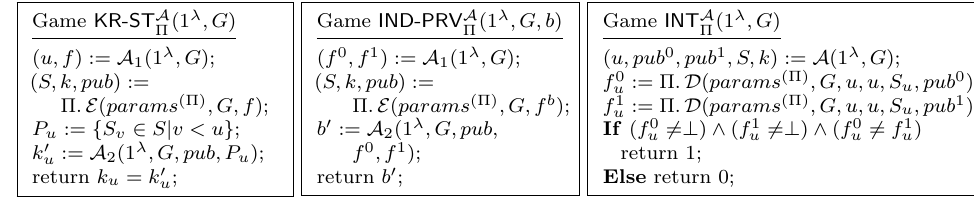
Figure 6: Games defining KR-ST , IND-PRV and INT security for KAS-AE Π = (Π . E , Π . DER , Π . D ). Here, in KR-ST and IND-PRV games, the adversary A = ( A 1 , A 2